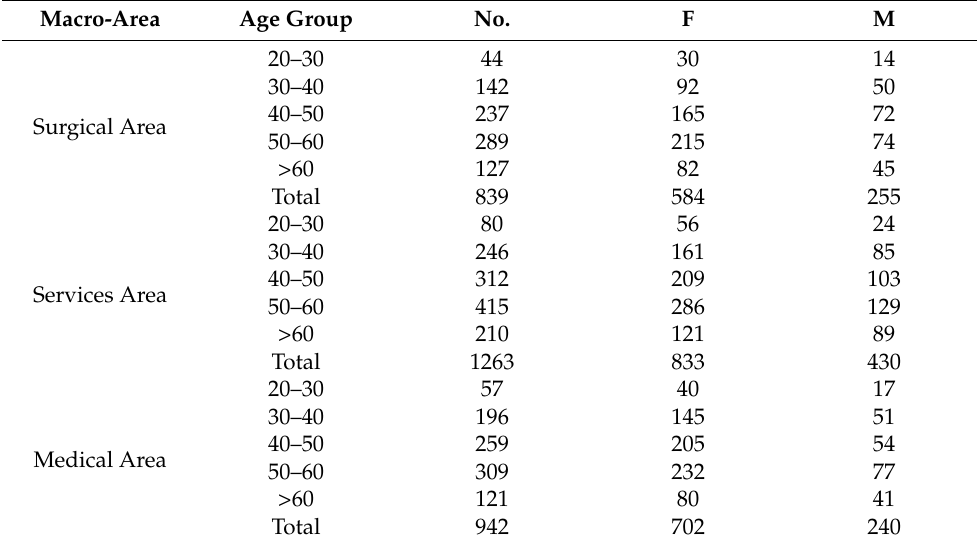
Table 3. Distribution by macro-area, age group, and gender (F = females; M = males) of AOU-SS healthcare workers